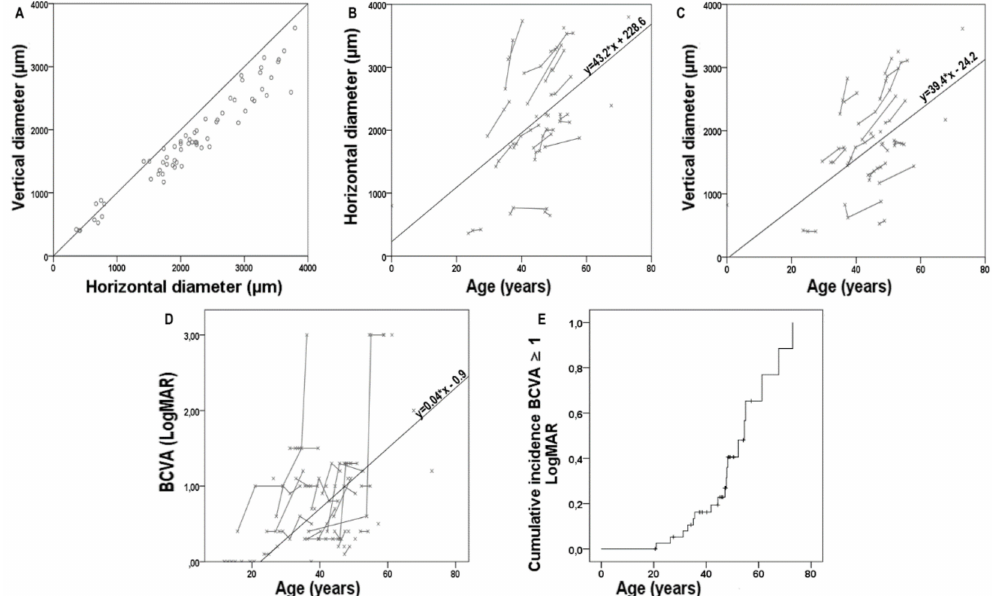
Figure 3. The scatterplots of all the horizontal and vertical diameters ( A ) of the central hyperautoflu- orescent (hyperAF) ring as seen on the short-wavelength fundus autofluorescence, plotted together. The black line is the reference line. ( B , C ) are the scatterplots of the same horizontal ( B ) and vertical ( C ) measurements grouped per patient and plotted with age. ( D ) The scatterplot of all best cor- rected visual acuity (BCVA) measurements available plotted with age. Each grey line represents the measurements from a single subject. In ( B – D ), the black line is the function of the mean regression slope and intercept derived from the individual regression slopes and intercepts of patients with the available longitudinal data. ( E ) Kaplan–Meier survival curves showing the cumulative incidence of BCVA ≥ 1 LogMar in the best eye for RPGR ORF15 -related cone and cone-rod dystrophies in patients as a function of